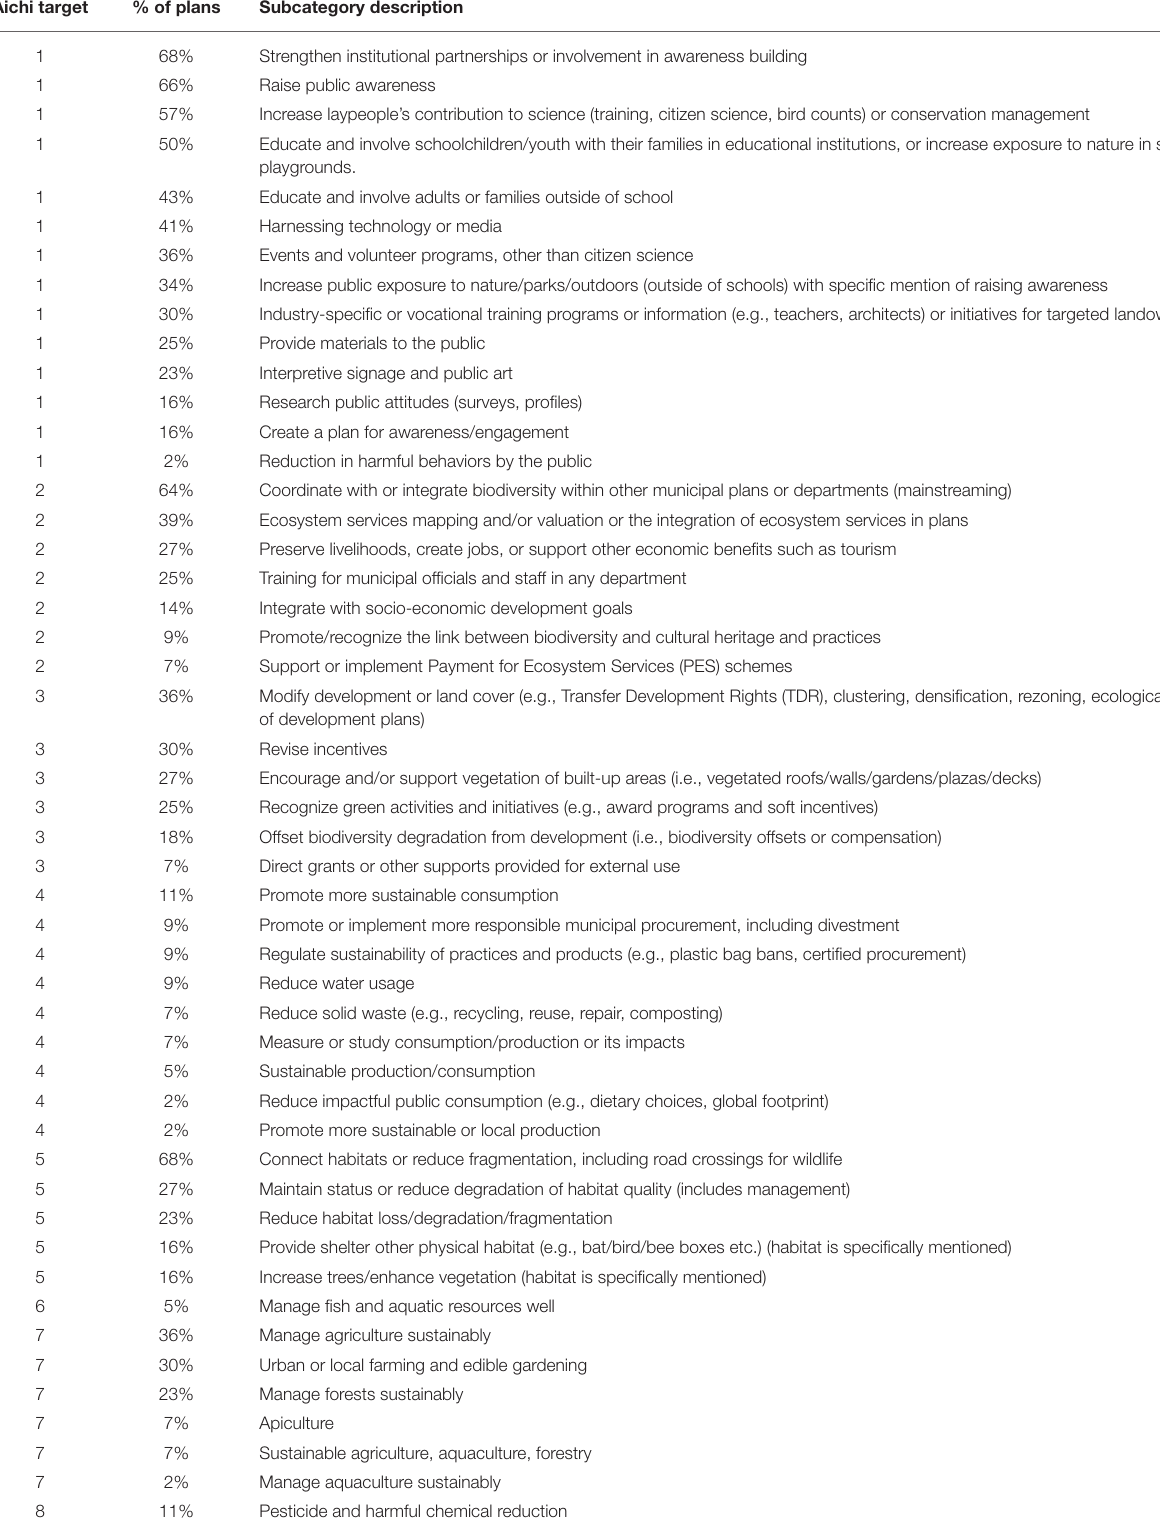
TABLE 2 | List of the subcategories identified within each of the Aichi Target themes (or, if there is not a theme, “n/a”) and their prevalence as a percentage of the plans. Aichi